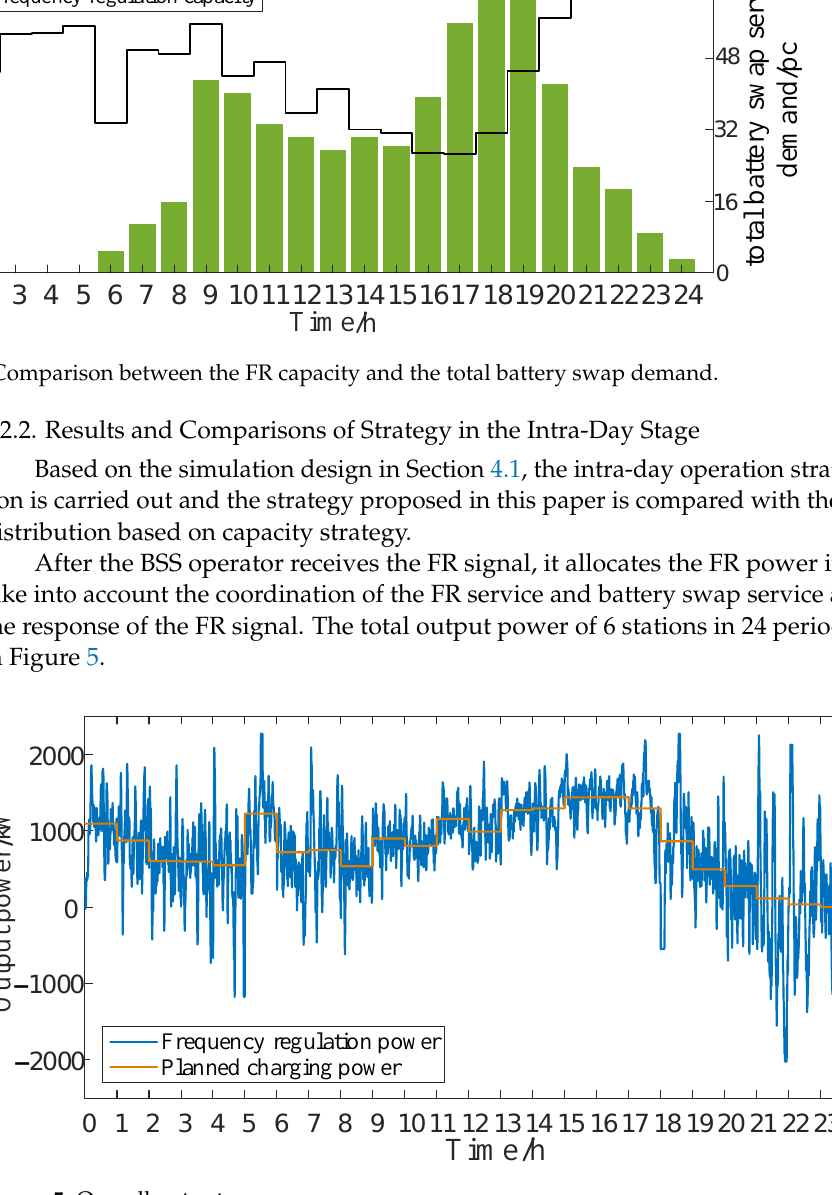
Figure 5. Overall output power.